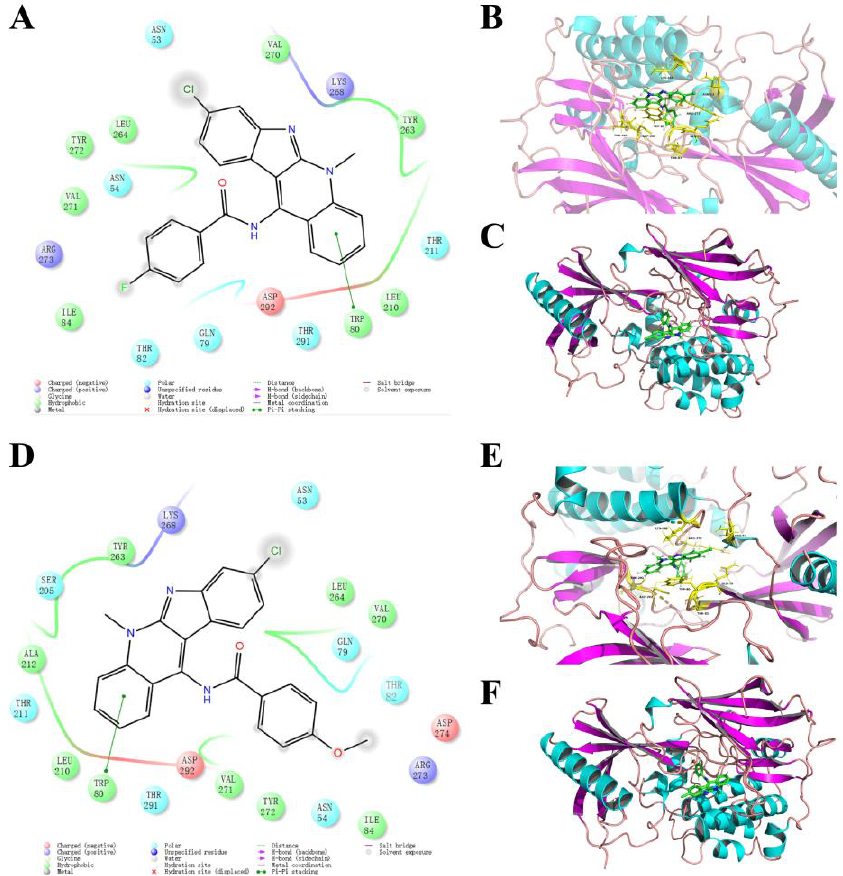
Figure 5. Molecular docking between compounds C5 or C8 and AKT proteins. Different colours in A and D indicated different types of amino acids, and different colours in B, C, E and F indicated different structures of the protein. ( A ) 2D diagram of AKT interacting with small molecule ligand compound C5 . ( B ) Diagram of compound C5 binding interaction with AKT protein. ( C ) Overall view of compound C5 binding to the AKT protein. ( D ) A 2D diagram of AKT interacting with small molecule ligand compound C8 . ( E ) Diagram of compound C8 binding interaction with AKT protein. ( F ) Overall view of compound C8 binding to the AKT